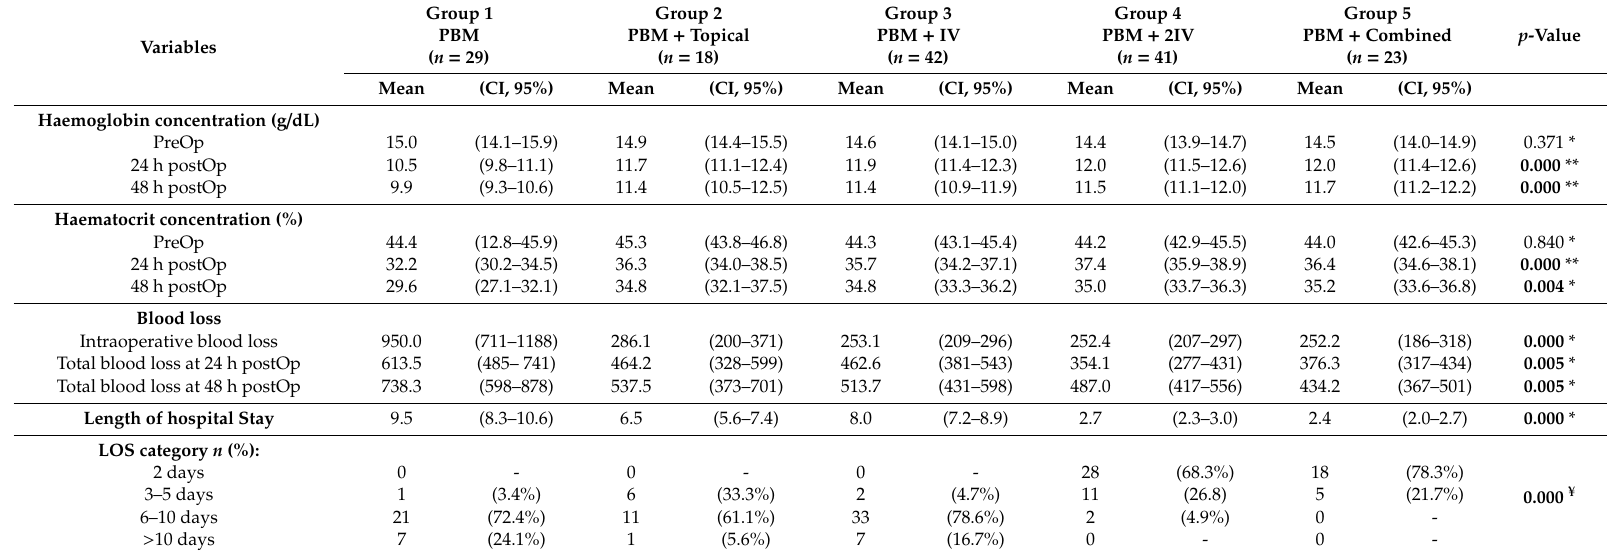
Table 2. Drop of haemoglobin and haematocrit and blood loss variables by group of